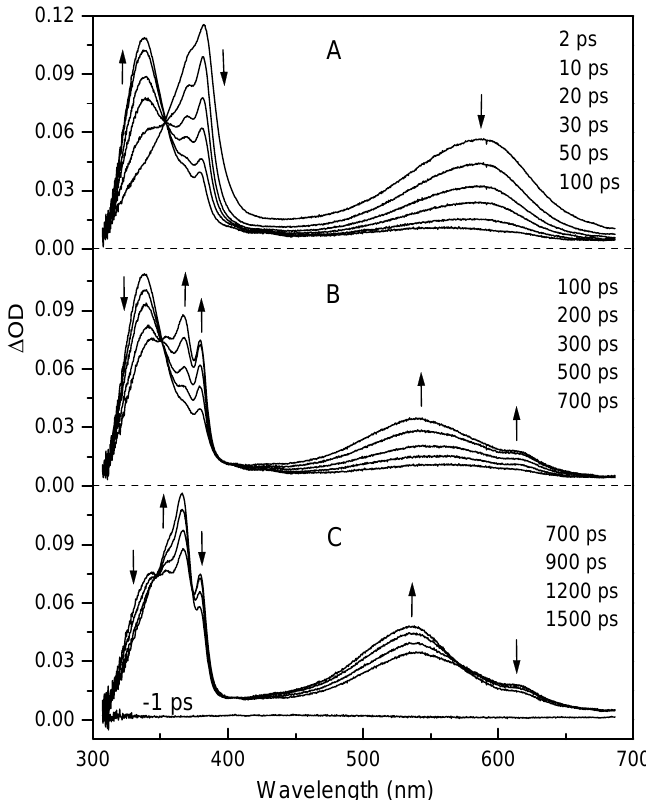
Figure 1. Transient absorption spectra of a solution of 44BPY (10 -2 M) and DABCO (0.5 M) in a mixture of acetonitrile and 32% water by volume, at different time delay after 266 nm excitation: (A) 2-100 ps, (B) 100-700 ps, and (C) 700-1500 ps. Vertical arrows indicate the signal